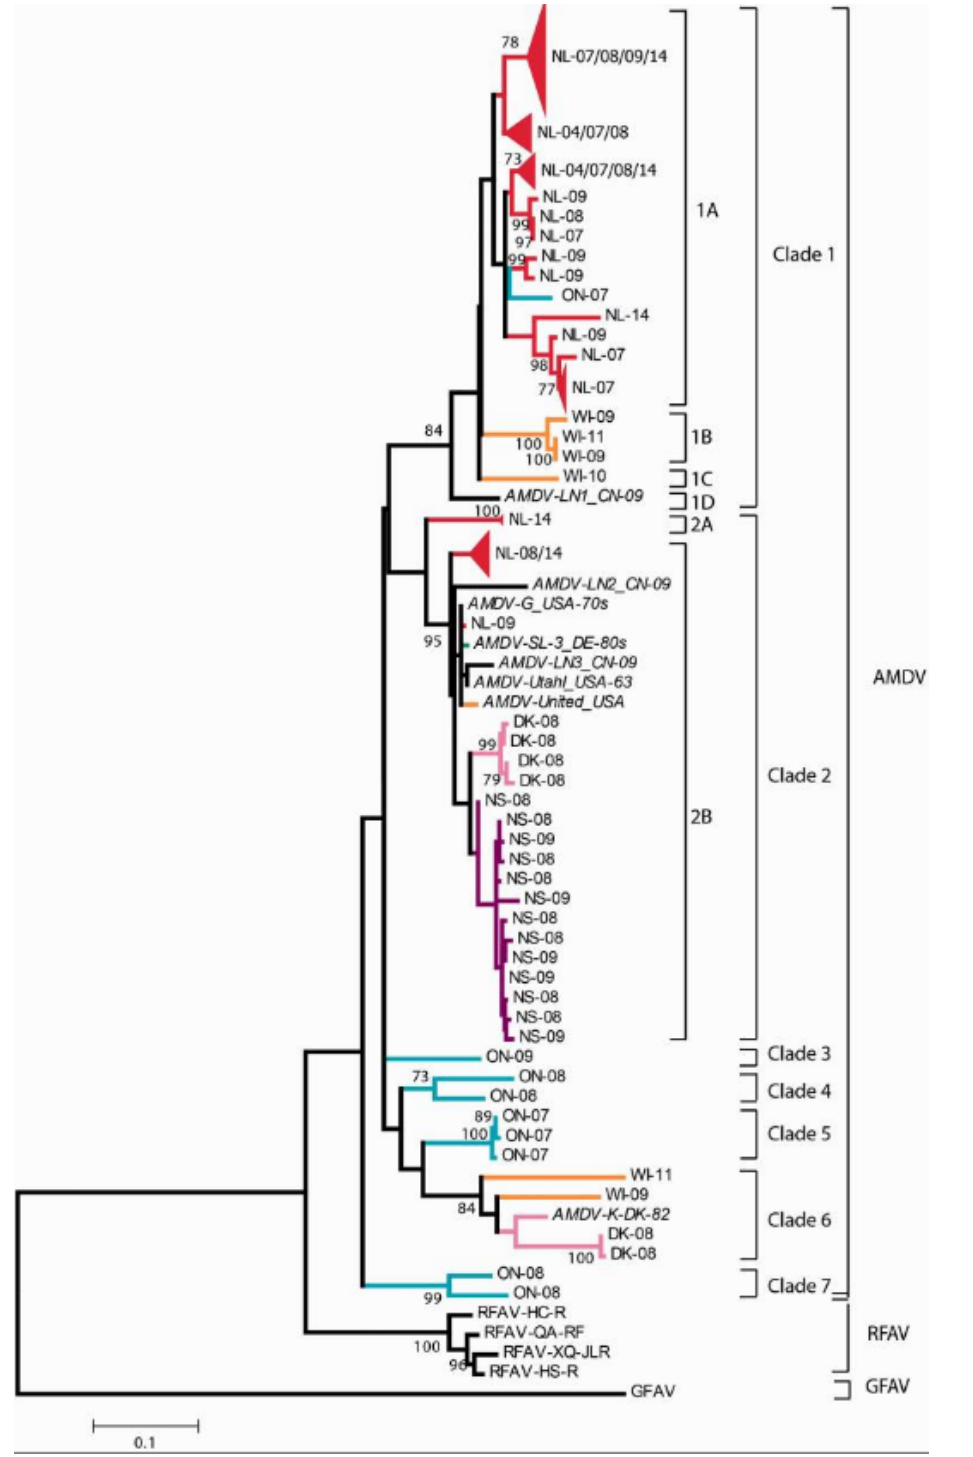
Figure 1. A phylogenetic analysis of partial AMDV NS1 sequences in sequences originating from different areas of the world. The evolutionary history of a fragment of the NS1 region (nt 1207–1690) was inferred using the maximum-likelihood method based on the HKY model (identified as the best-fitting model) in MEGA6. The discrete gamma distribution was used to model the differences in the evolutionary rate across sites (+G = 0.4098 was modelled). The evolutionary history of selected sites was invariable in the rate variation model ((+ I ), 32.514% of sites). The outcome of the bootstrap analysis is shown next to the nodes, and the branch lengths are proportional to the genetic distances indicated by the scale bar. Large groups of sequences originating from the same location and clustered in the same clade were collapsed into a triangular shape at the nodes. The